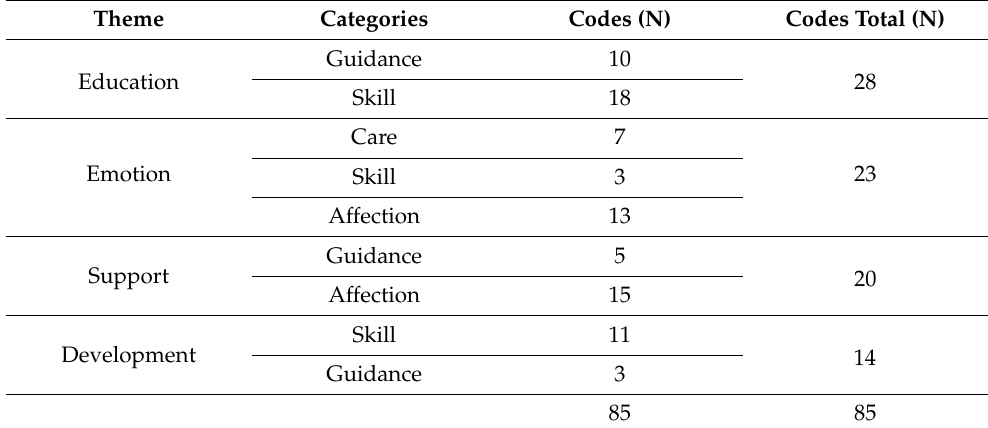
Table 7. Distribution of categories and codes for the metaphors that families produced about educa- tors’